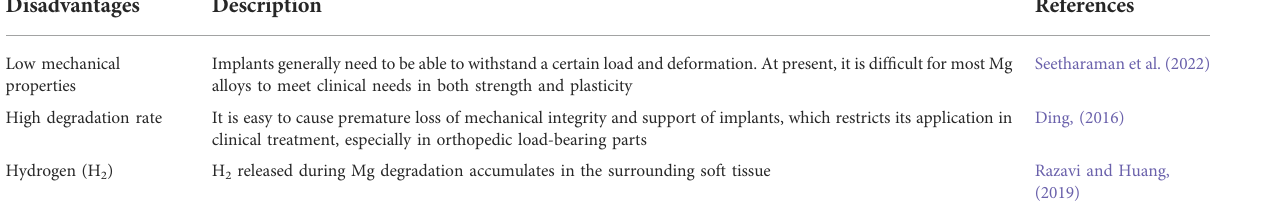
TABLE 2 Disadvantages of Mg alloys for biomedical